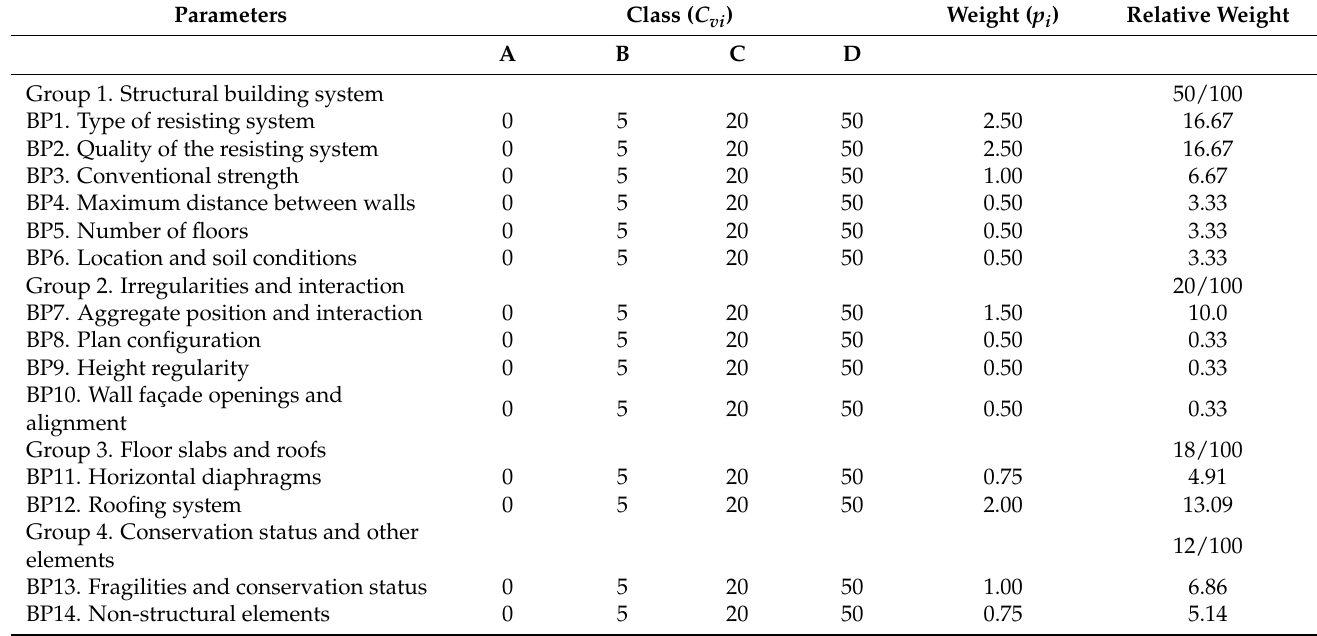
Table 1. Parameters for the VIM approach according to Ramirez Eudave and Ferreira